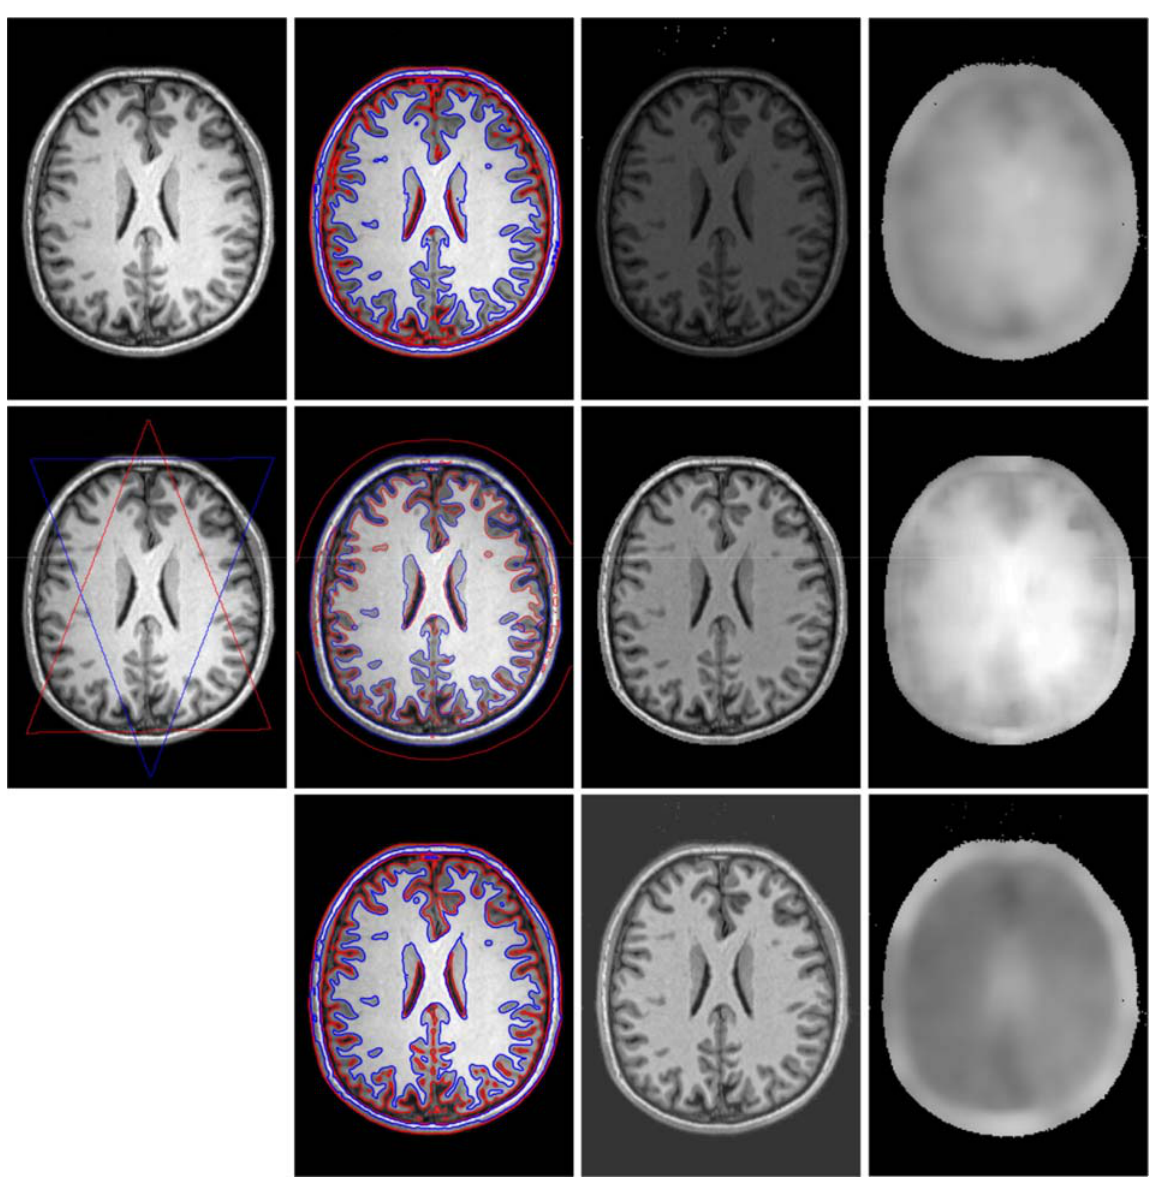
Fig 11. Comparisons of Li ’ s model, LSACM and our model for MR brain image. Column 1 is the original image with red and blue initial contours. Column 2 to 4 is the final segmentation results, the corrected images and the estimated bias field images, respectively. Row 1 to 3 is the results of Li ’ s model, LSACM and our model,